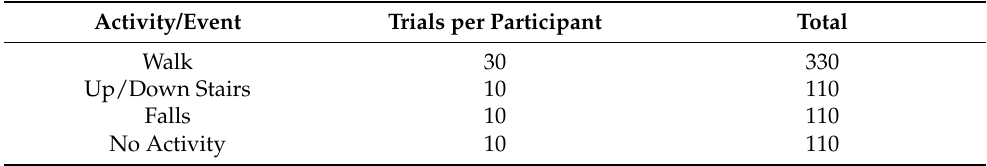
Table 2. Summary of trials performed by the participants.